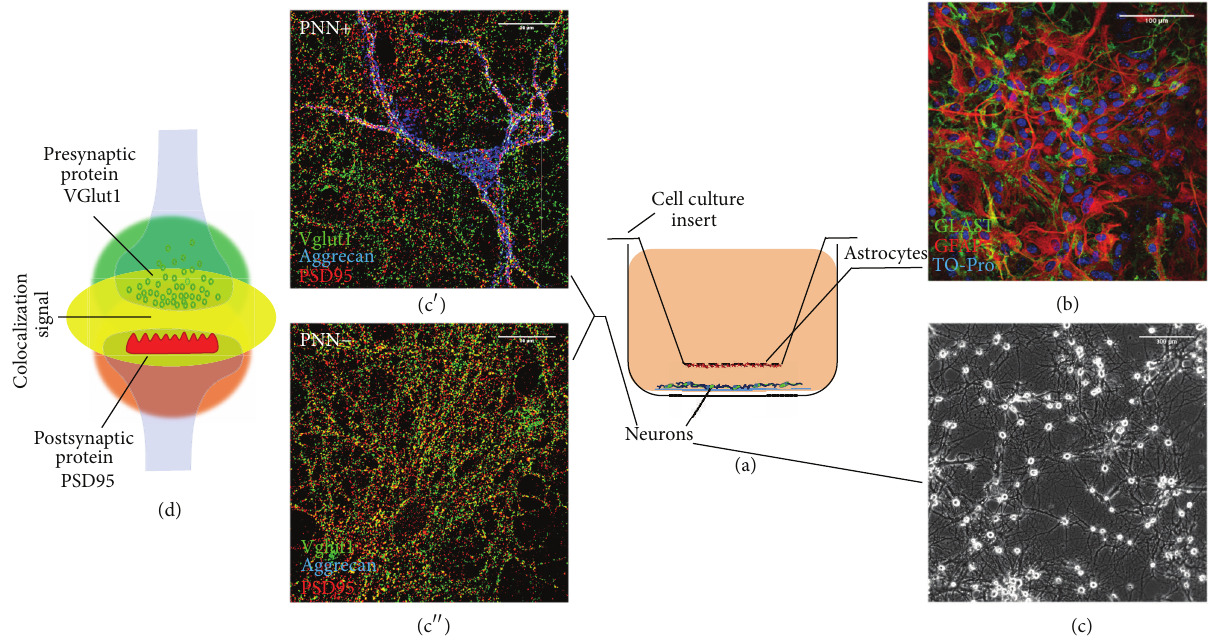
Figure 2: Neuron-astrocyte coculture for the study of synaptogenesis. A schematic view of the neuron-astrocyte indirect coculture system is presented. (a) Primary embryonic day 15 mouse hippocampal neurons are cultivated on coverslips in the presence of primary cortical astrocytes maintained as monolayers in cell culture inserts (b). Thereby, astrocytes and neurons share the same medium in the absence of membrane-mediated contacts. With the use of this system, neurons can be cultivated for up to 4 weeks and form active neuronal networks (c) in completely defined media [132], suggesting a reliable model for synaptogenesis studies. A subgroup of neurons can develop PNNs, as indicated by a specific marker (c 󸀠 and c 󸀠󸀠 ). Presynaptic and postsynaptic terminals can be visualised using immunocytochemical labelling of presynaptic and postsynaptic proteins. The overlap of pre- and postsynaptic puncta indicates the structural synapses (d). Quantification of synaptic puncta using an analysis software permits the quantitative evaluation of synapse formation in vitro under different treatment conditions. For experimental details see [129,